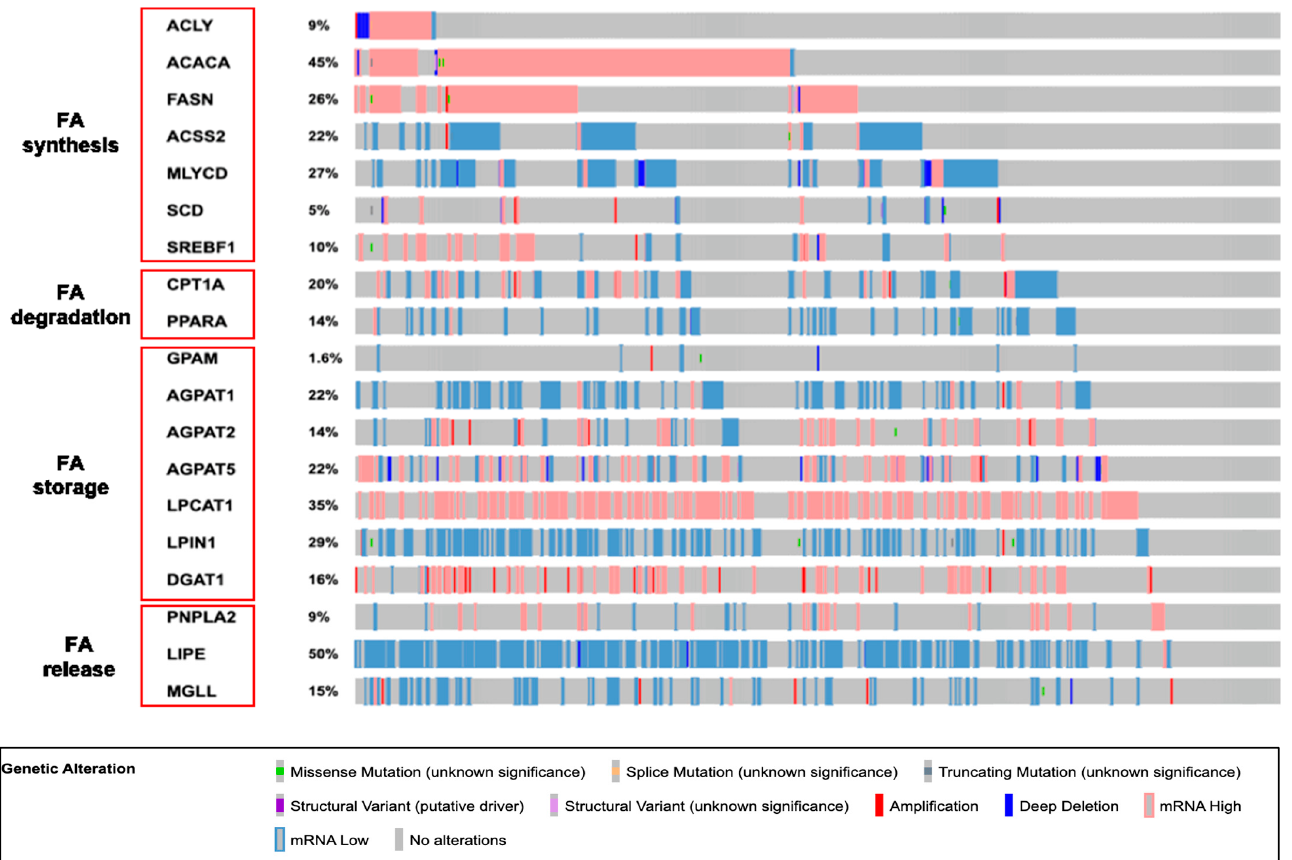
Figure 1. Oncoprints of fatty acid (FA) metabolism genes in the cancer genome atlas (TCGA, Pan-Cancer Atlas) PCa patient cohort (PRAD). About 88% of the tumors from 489 patients in PRAD showed altered gene copy number or expression of FA metabolism-related genes. ACLY: ATP citrate lyase; ACACA: acetyl-CoA carboxylase alpha (ACC); FASN: fatty acid synthase; ACCS2: acyl-CoA synthetase short-chain family member 2; MLYCD: malonyl-CoA decarboxylase; SCD: stearoyl-CoA desaturase; SREBF1: sterol regulatory element-binding transcription factor 1 (SPREBP1); CPT1A: carnitine palmitoyltransferase 1A; PPARA: peroxisome proliferator-activated receptor alpha; GPAM: glycerol-3-phosphate acyltransferase; AGPAT: 1-acylglycerol-3-phosphate O-acyltransferase; LPCAT1: lysophosphatidylcholine acyltransferase 1; LPIN1: lipin 1; DGAT1: diacylglycerol O-acyltransferase 1; PNPLA2: patatin-like phospholipase domain containing 2; LIPE: lipase, hormone-sensitive; MGLL: monoglyceride